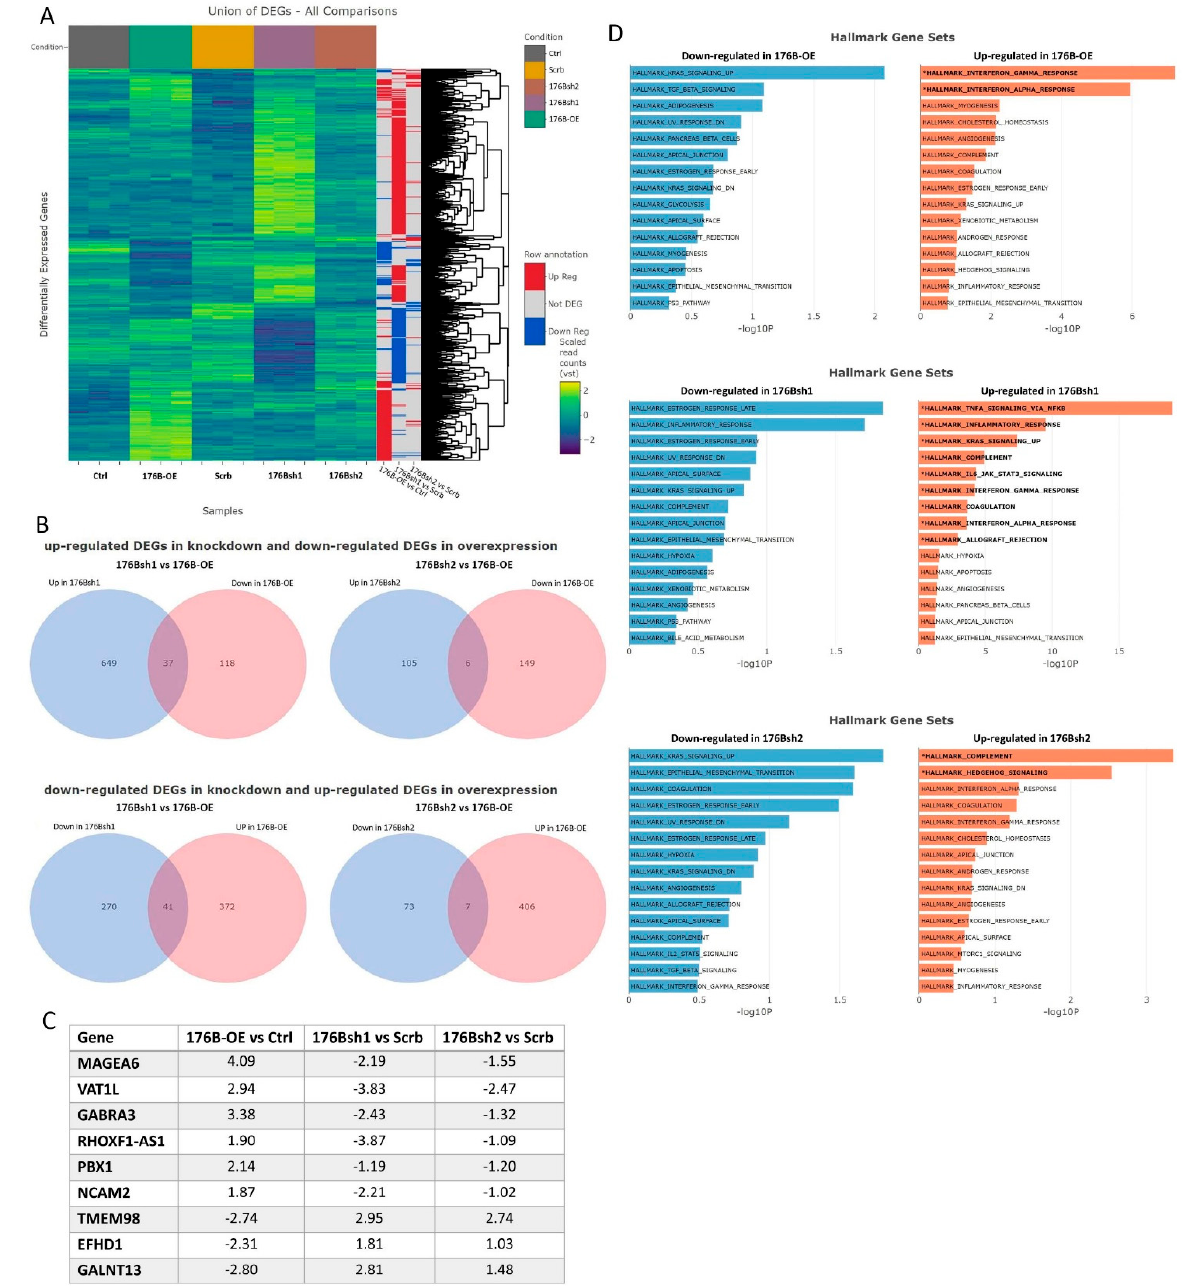
Figure 5. RNA sequencing gene expression analysis in MDA-MB-231 cell lines overexpressing TMEM176B or with TMEM176B gene silencing. ( A ) Heatmaps of all differentially regulated genes (DEGs) between control (Ctrl) and TMEM176B-overexpressing (176B-OE), and shRNA control (Scrb) and TMEM176B-silenced (176Bsh1, 176Bsh2) cell lines to give an overview of the transcriptomic changes. The colored side bars of the heatmap indicate whether the gene is differentially expressed between groups as comparisons stated beneath the colored bars. ( B ) Venn diagrams showing the overlap between the DEGs identified for the cell lines with TMEM176B-silenced and reciprocally expressed in the TMEM176B-overexpressing cells, relative to the respective controls. ( C ) Genes that were identified as significantly differentially expressed in opposite directions between TMEM176B-overexpression and TMEM176B-silenced cell lines. Reported values are the log2 fold changes for their respective controls. ( D ) Functional enrichment via over-representation analysis between control and TMEM176B overexpressing cells, as well as shRNA control (Scrb) and TMEM176B-silenced cells in hallmark gene sets. Gene sets reported in bold with an asterisk are significantly enriched at adjusted p -value < 0.05.